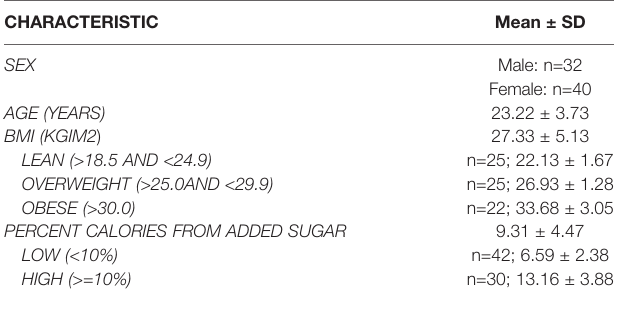
TABLE 1 | Characteristics for all participants